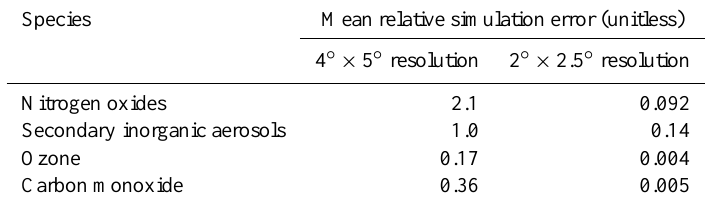
∗ Mean taken for operator durations ≤